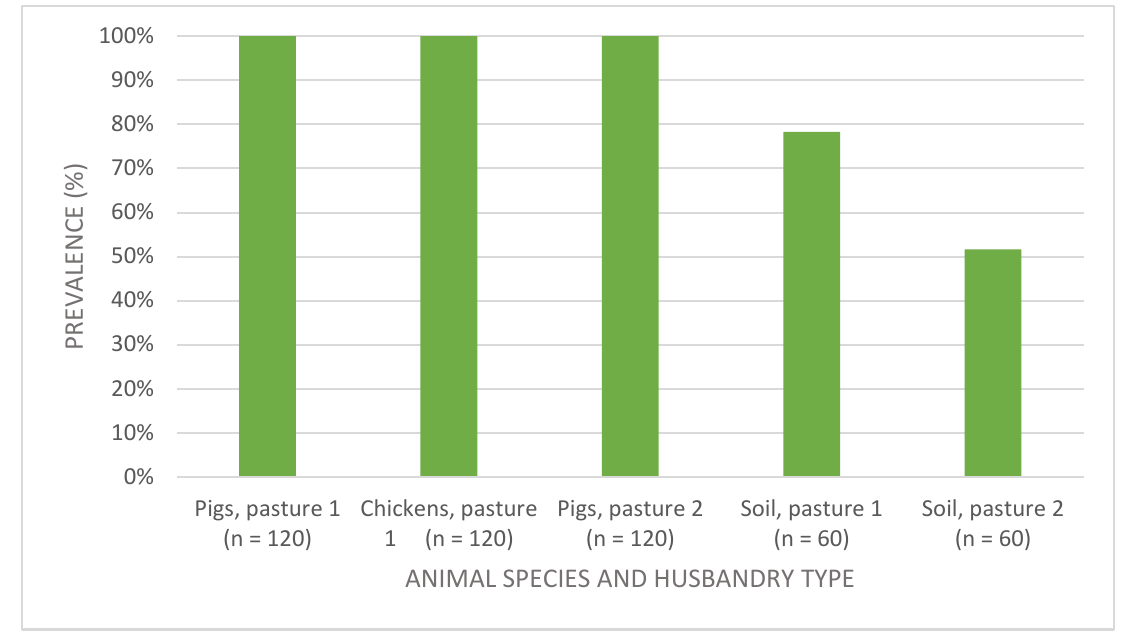
Figure 4. Prevalence of Escherichia coli in animal and soil samples from two husbandry types. Pasture 1: pigs and chickens were kept together (mixed husbandry). Pasture 2: pigs alone.